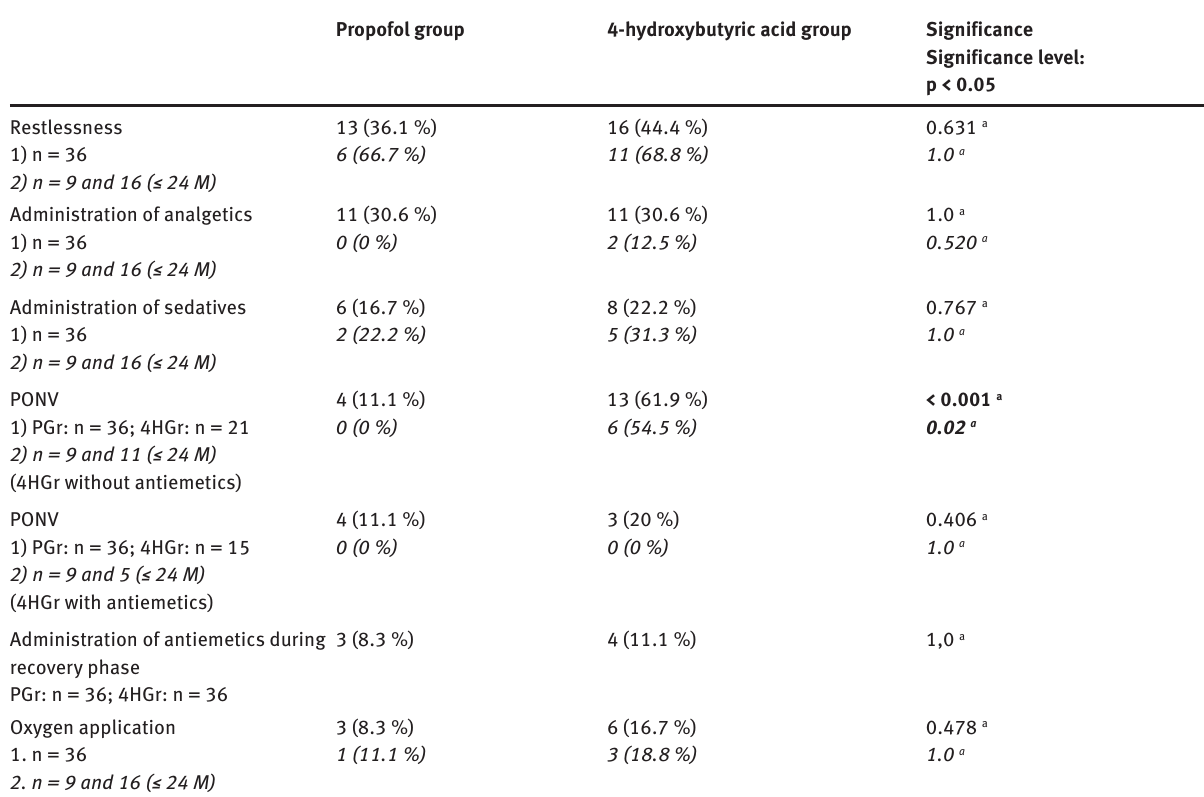
Table 6: Events and measures during the recovery phase